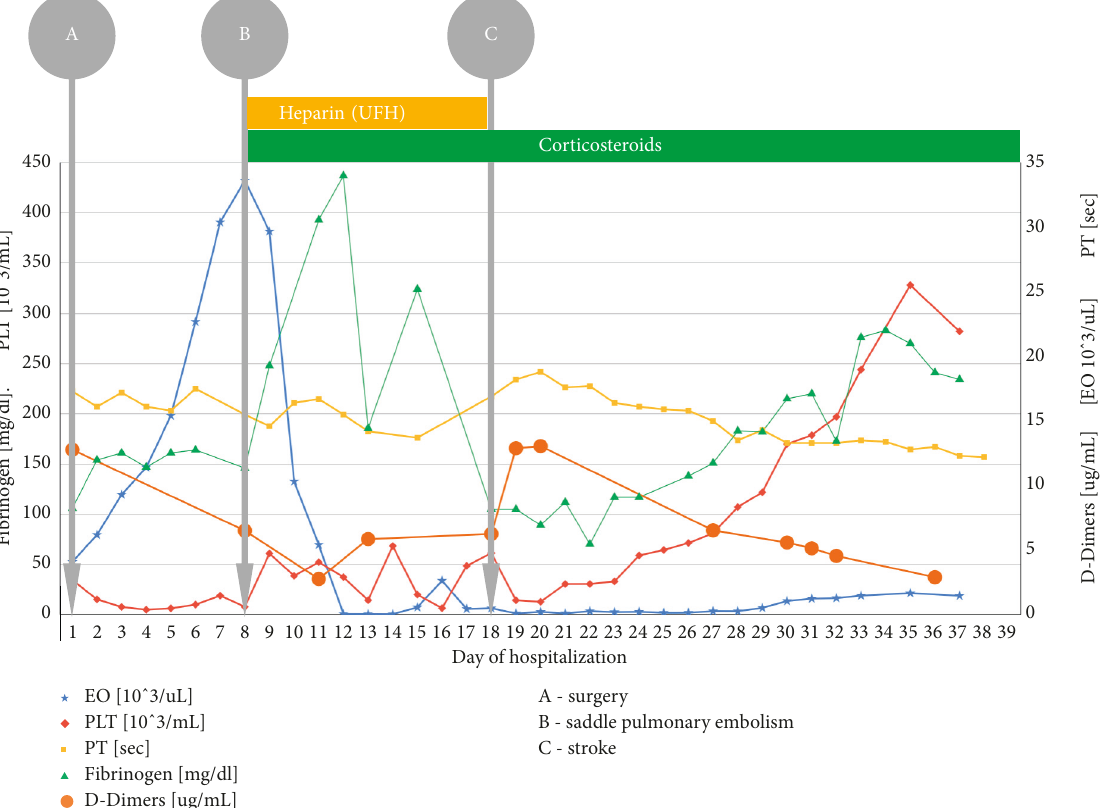
Figure 1: Timeline showing laboratory results changes, significant clinical events, and treatment.